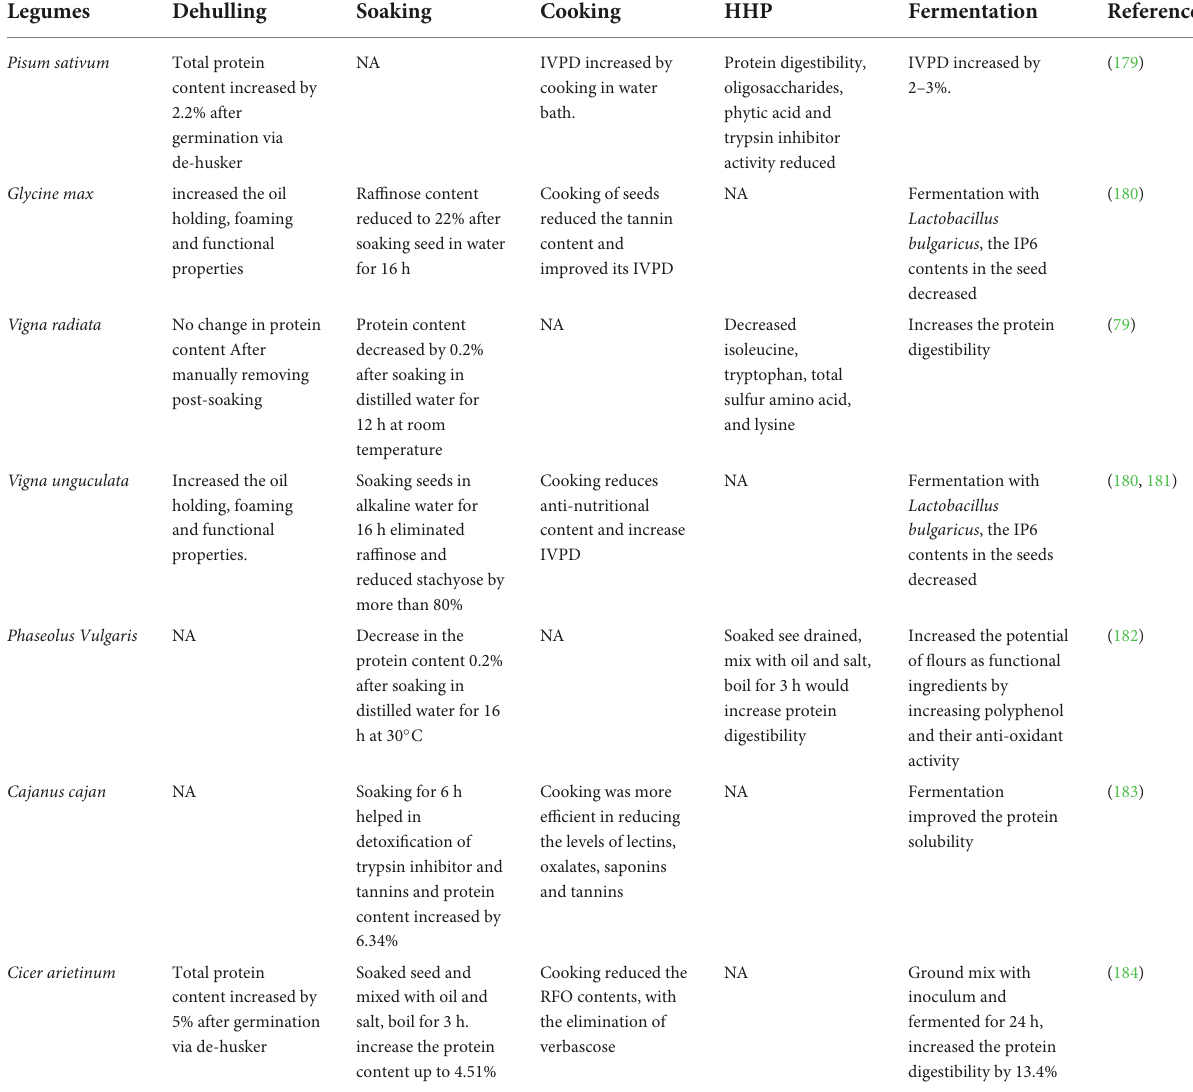
TABLE 3 Effect of processing techniques on protein in different legumes.